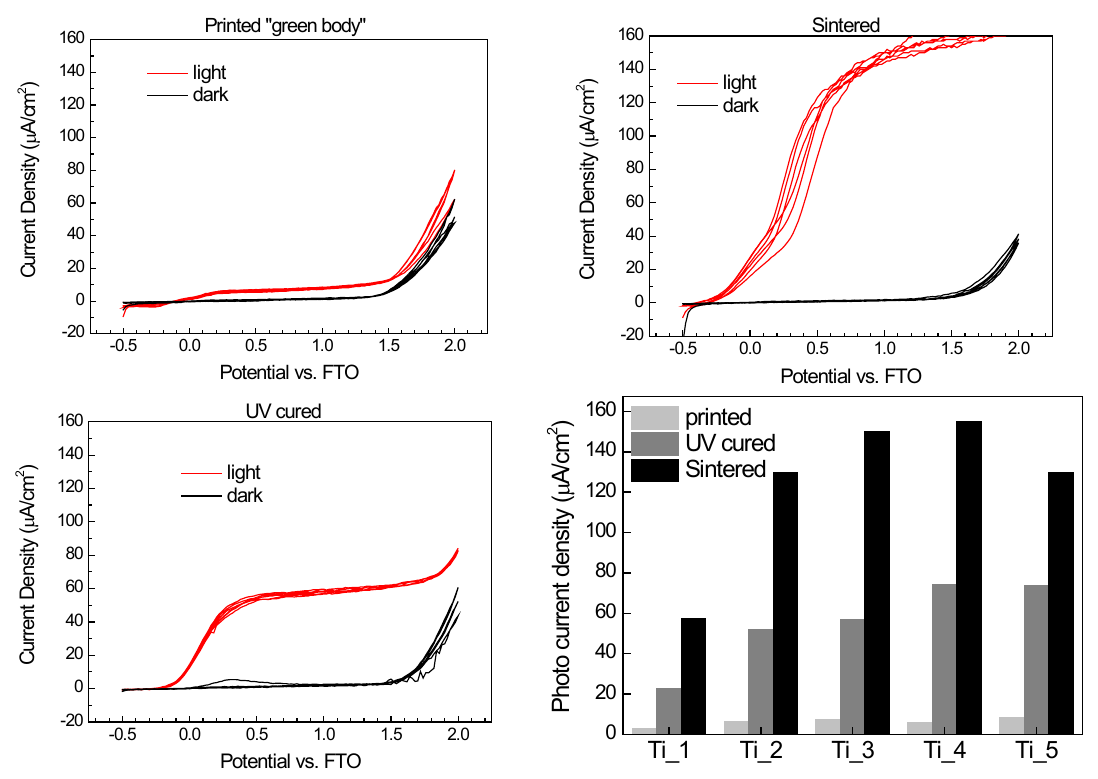
Figure 8. Comparison of generated photocurrents for Ti_3_3L sample. Printed “green body” electrode ( top left ), thermally sintered ( top right ), UV cured ( bottom left ) and the summary of photocurrent density (μA/cm 2 ) at 1 V potential for all the studied sample sets ( bottom right